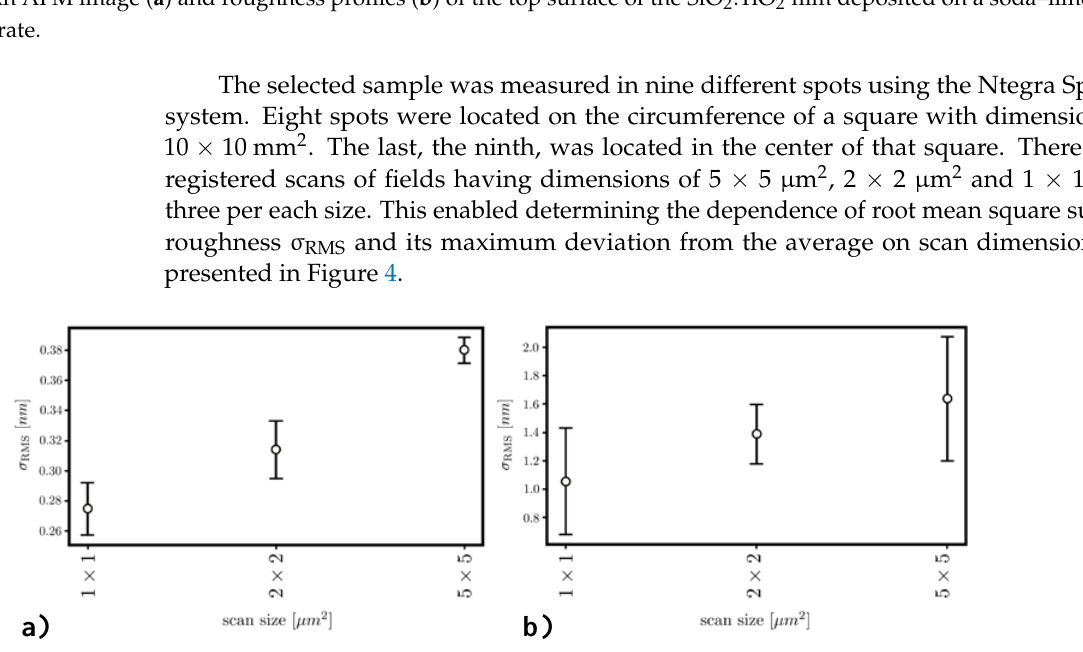
Figure 4. Variation of the root mean square surface roughness and its maximum deviation from the average concerning scan field dimensions for ( a ) SiO 2 :TiO 2 film deposited on a BK7 glass substrate and ( b ) a bare substrate.